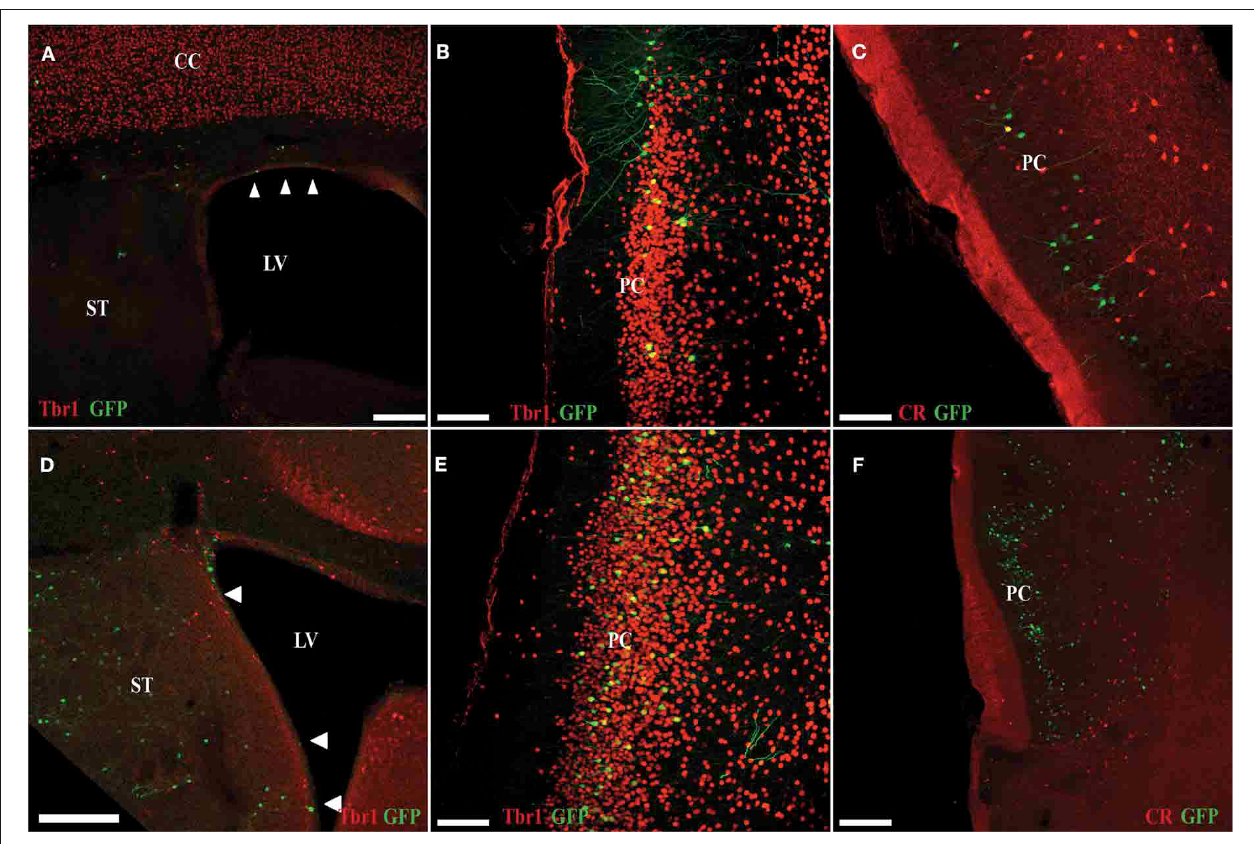
FIGURE 5 | Electroporation of a GFP plasmid into pallial (A–C) and subpallial (D–F) areas of E11 mice (sacrificed at P5). (A–C) Many of GFP cells that originate in the ventricular zone of the pallium (green) do not co-express Tbr1 (red; A,B ). (C) Pallial-derived GFP cells do not